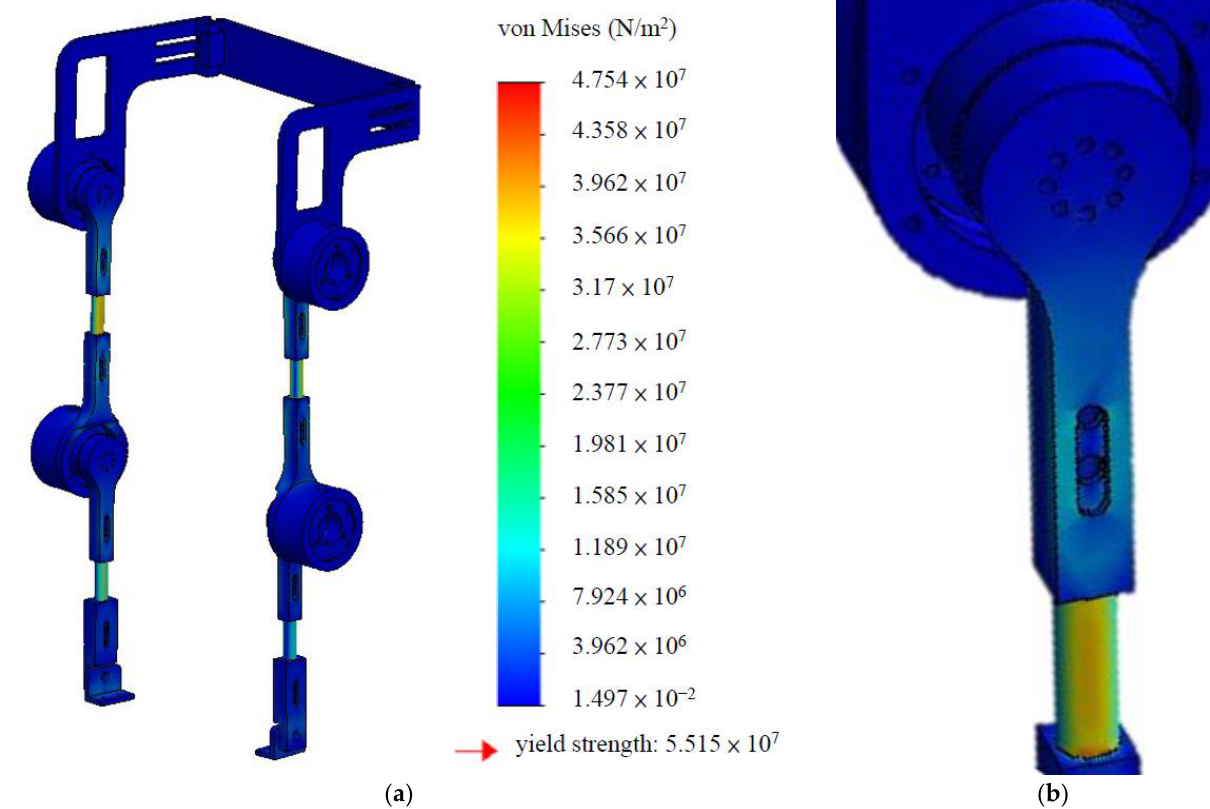
Figure 3. ( a ) Stress analysis simulation of the LLRE-II; ( b ) close-up view of the areas with material tensions.